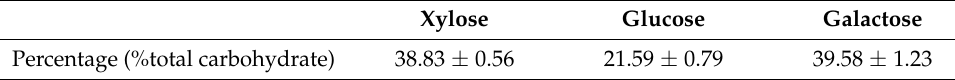
Table 2. Monosaccharide composition of intracellular polysaccharides.